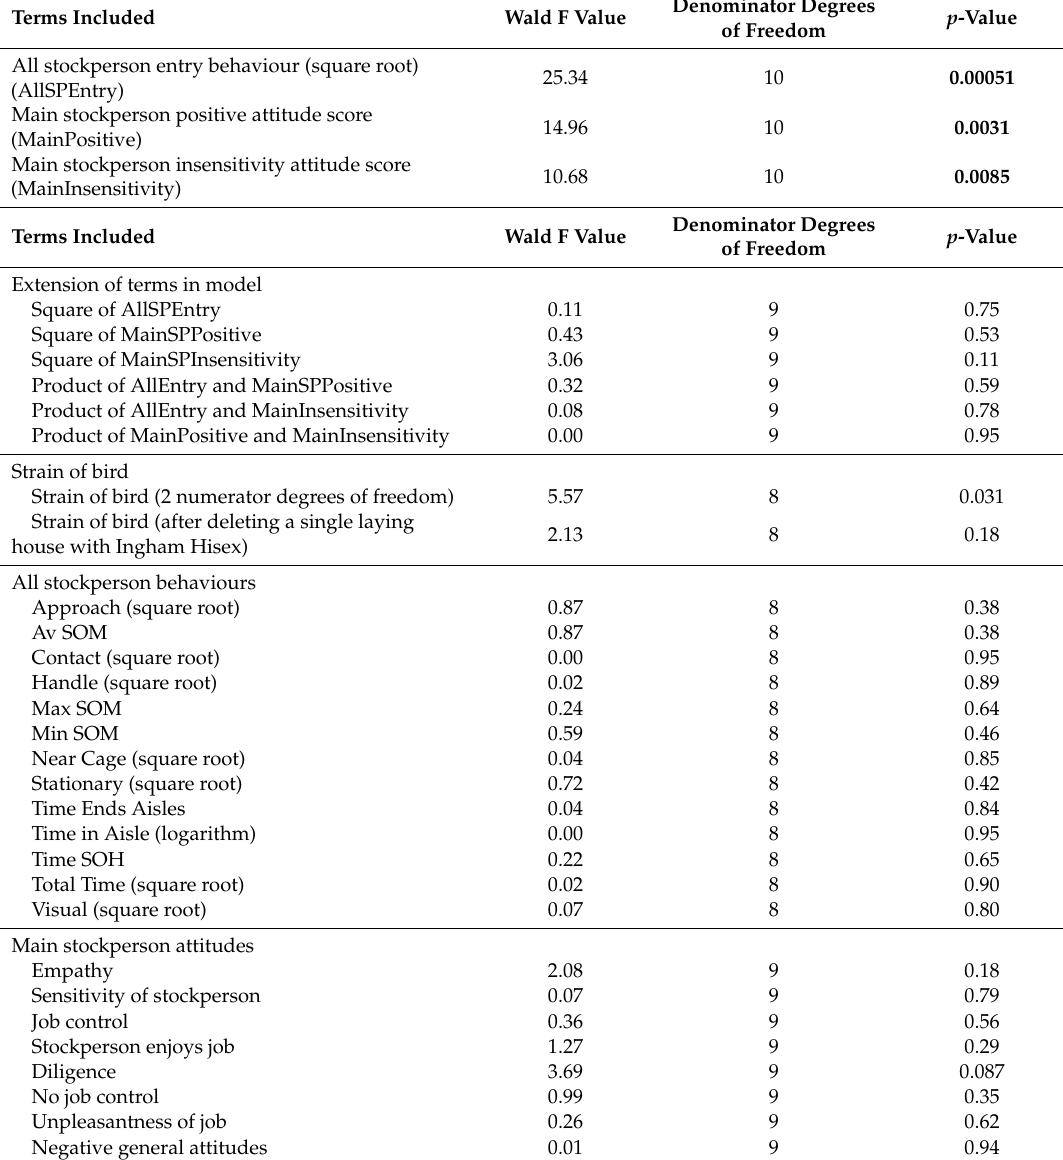
Table 7. Tests for including and excluding terms in the model relating main stockperson noise (square root transformed) to strain of bird, all stockperson behaviours except noise and attitudes. Tests for the inclusion of terms for other physical features of the laying house, main stockperson behaviours had p > 0.1, and thus are not presented. Except where indicated, all F tests have 1 numerator degrees of